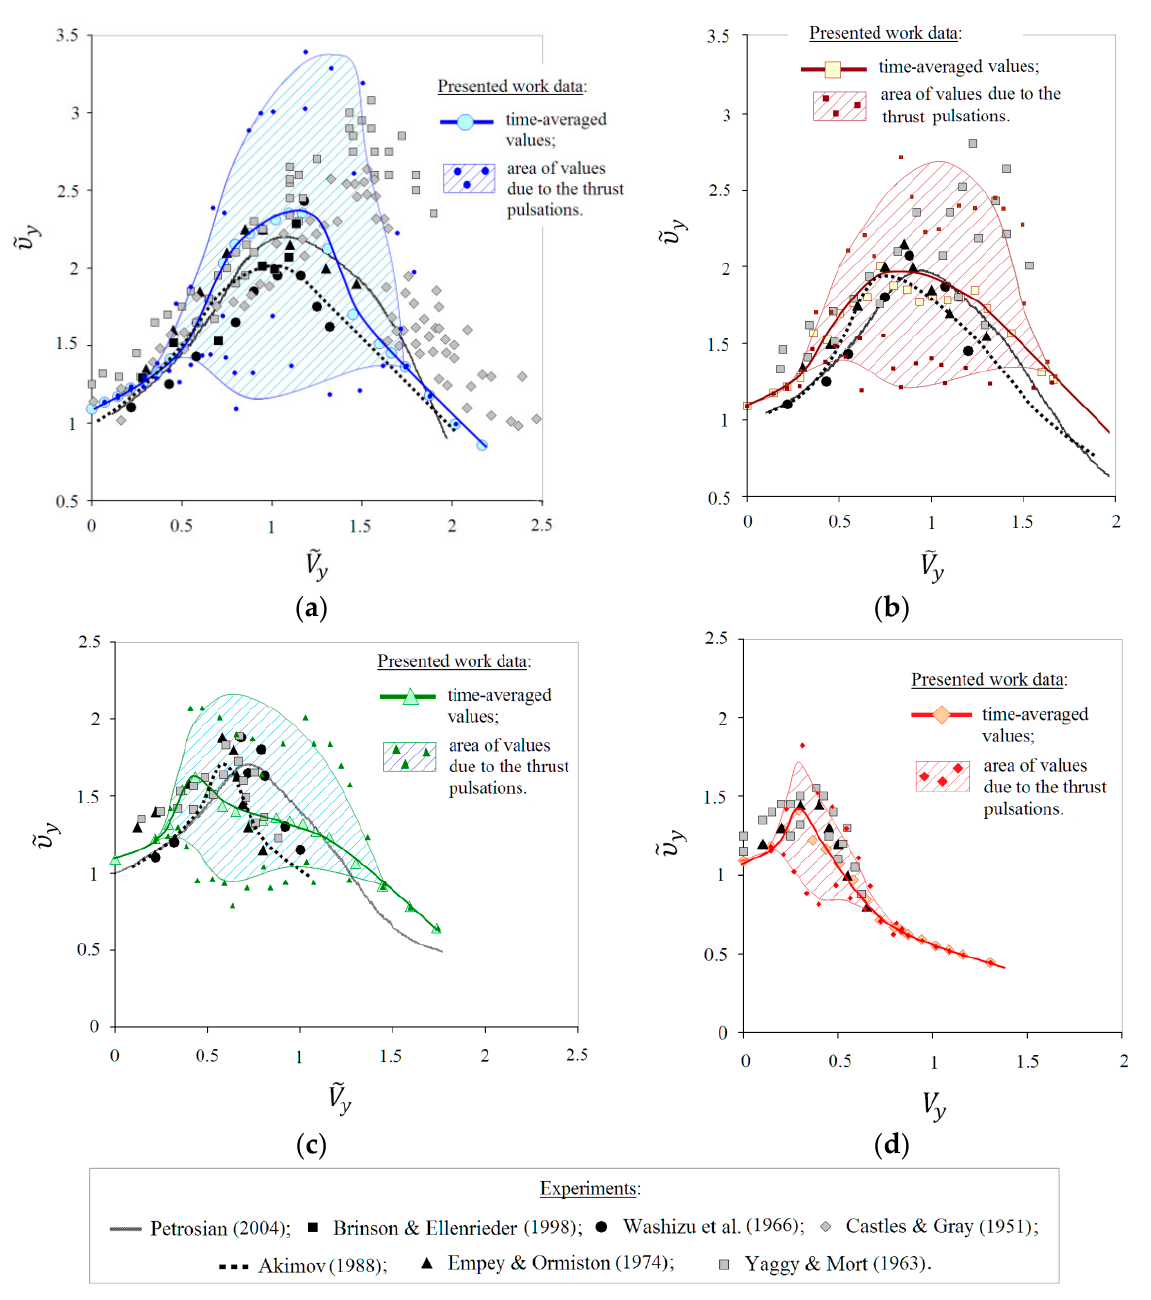
Figure 14. Dependencies of the UR, LR and total (UR+LR) torque coefficients C Q vs. non-dimensional vertical descent speed (cid:101) V y at α R = 30–90 ◦ . ( a ) α R = 90 ◦ ; ( b ) α R = 70 ◦ ; ( c ) α R = 50 ◦ ; ( d ) α R = 30 ◦ .